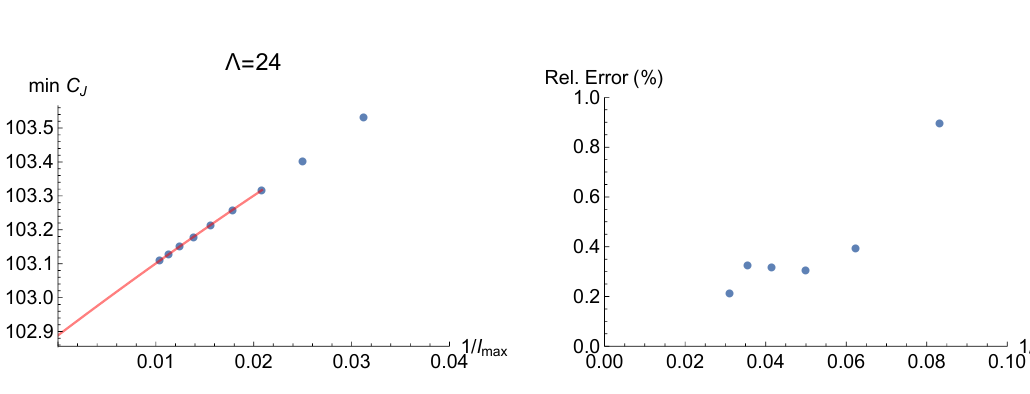
Figure 9 . Left: the lower bounds on C J for interacting theories with E 8 (cid:13)avor group, at derivative order (cid:3) = 24 and across a range of spin truncations ‘ max . Also shown is an extrapolation to ‘ max ! 1 using the quadratic ansatz (G.2). Right: the relative errors between ‘ max = 64 and the extrapolations to ‘ max ! 1 , at di(cid:11)erent